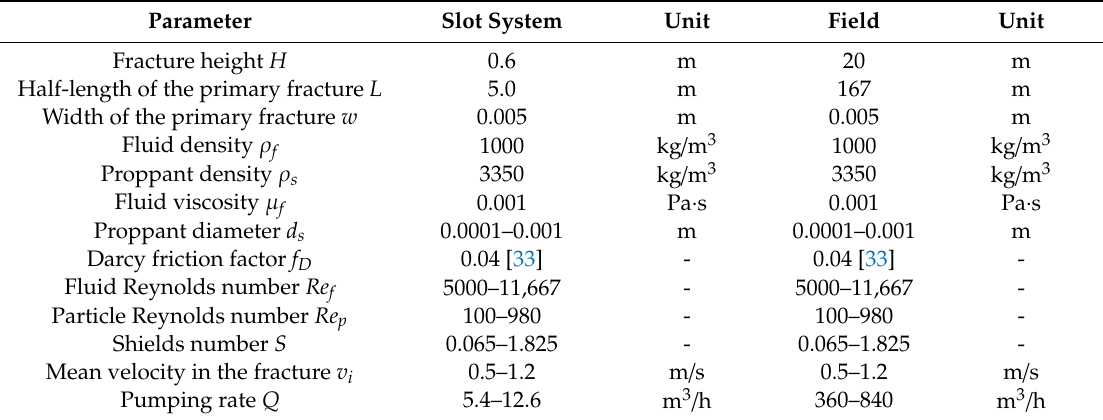
Table 1. Values of experimental parameters and dimensionless